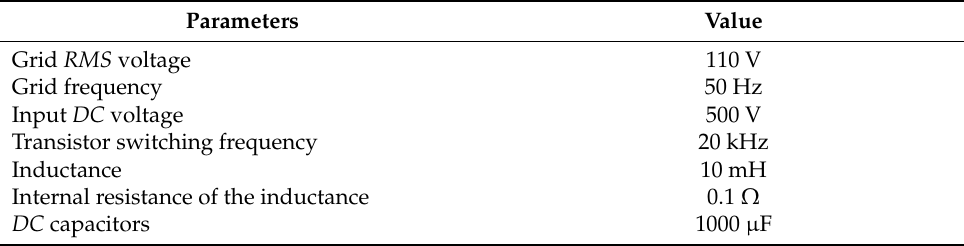
Table 1. Parameters of the system with a T-type